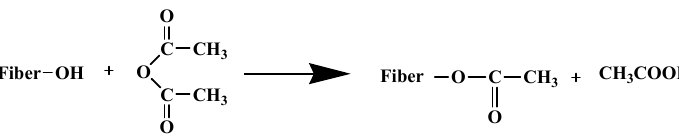
Figure 15. Chemical reaction of acetic anhydride with cellulose (Taken from reference [80] with permission of the Springer Nature).